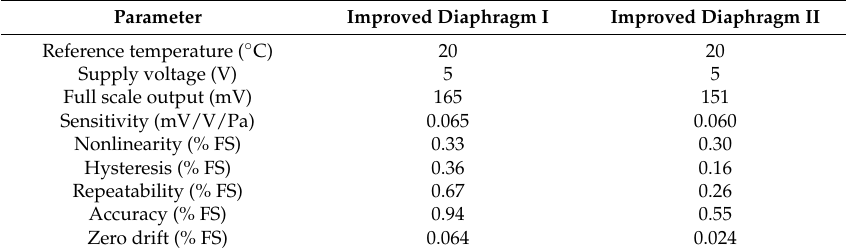
Table 3. The sensor performance of proposed sensing chips.